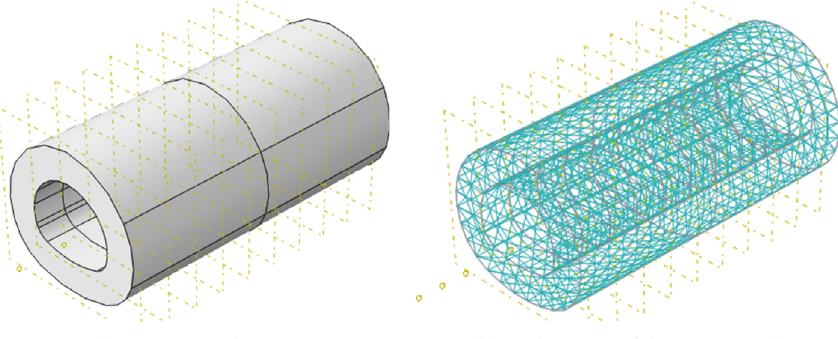
Figure 6: Grouting circle model.